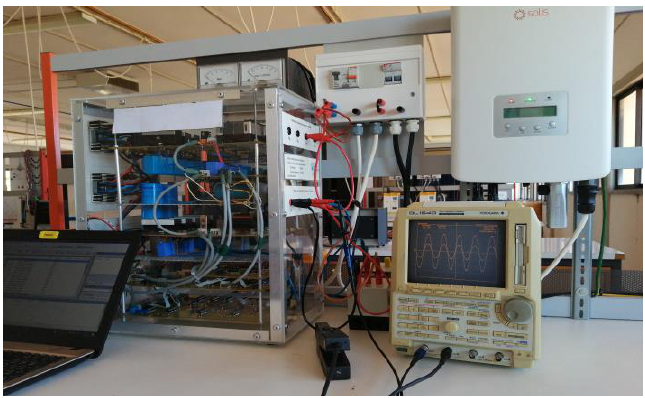
Figure 6. Prototype of the implemented solar inverter testing system.